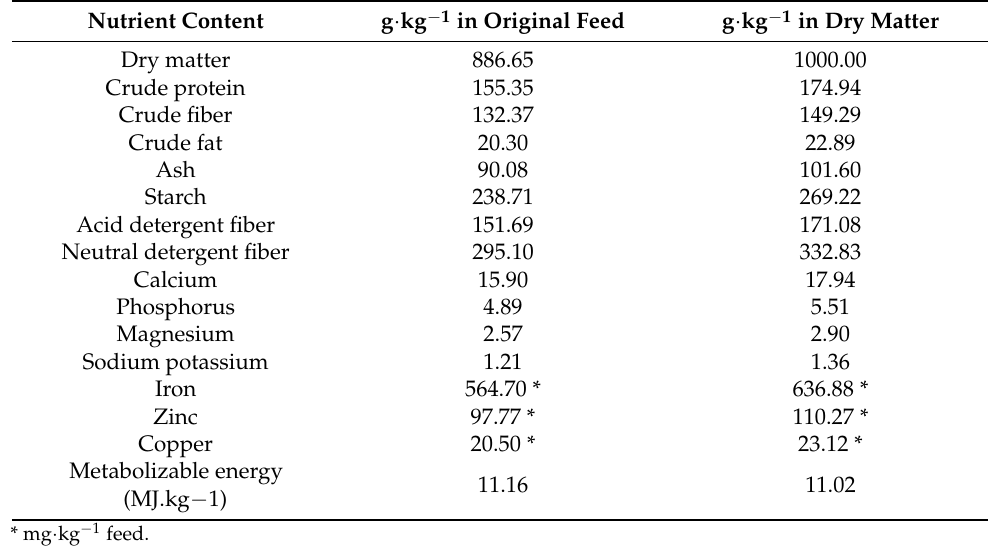
Table 1. Nutrient content of commercial granulated diet for growing rabbits.